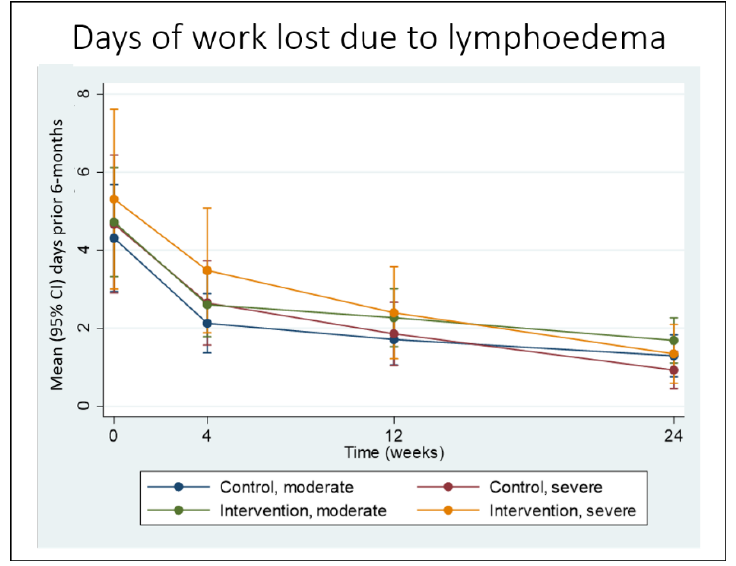
Figure 6. Workdays lost due to lymphedema by group and stage in the previous one month.